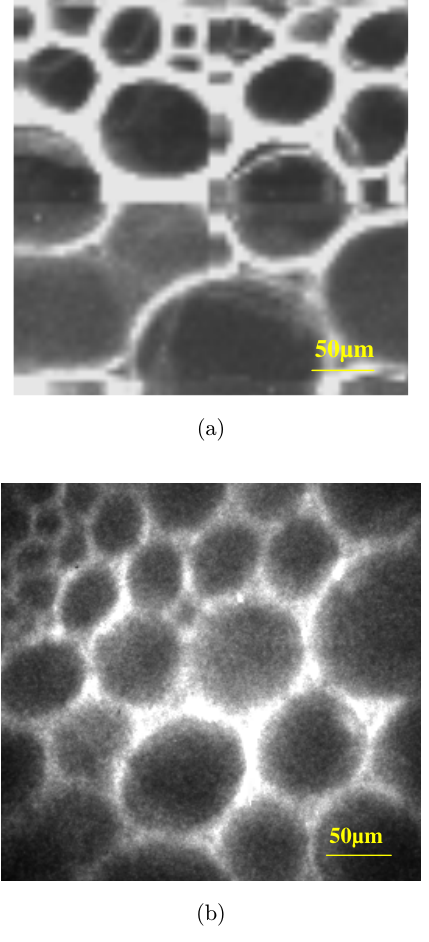
Fig. 6. Two-photon °uorescence images of prepared plant stem slide obtained by (a) bi-directional raster scanning mode and (b) stochastic scanning mode, respectively. The scale bar is 50 (cid:1)